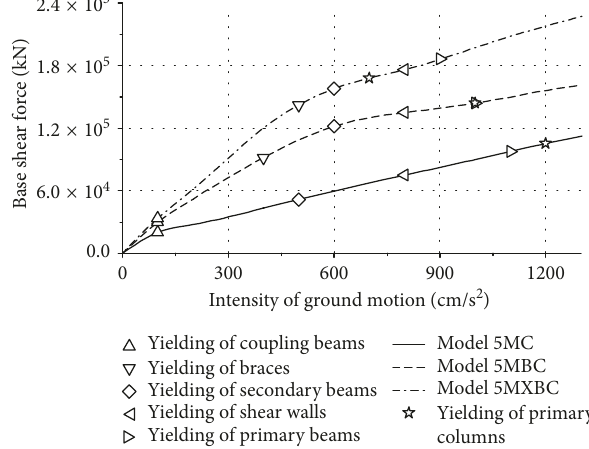
Figure 25: Component yielding order of three structure models under earthquake using IDA